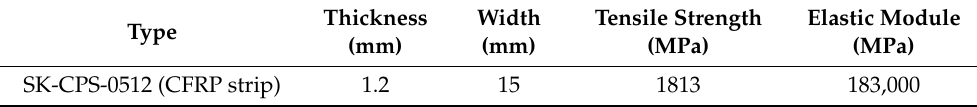
Figure 2. Stress–strain relationship of the FRP strip. Table 1. Dimension and mechanical properties of the FRP strip.